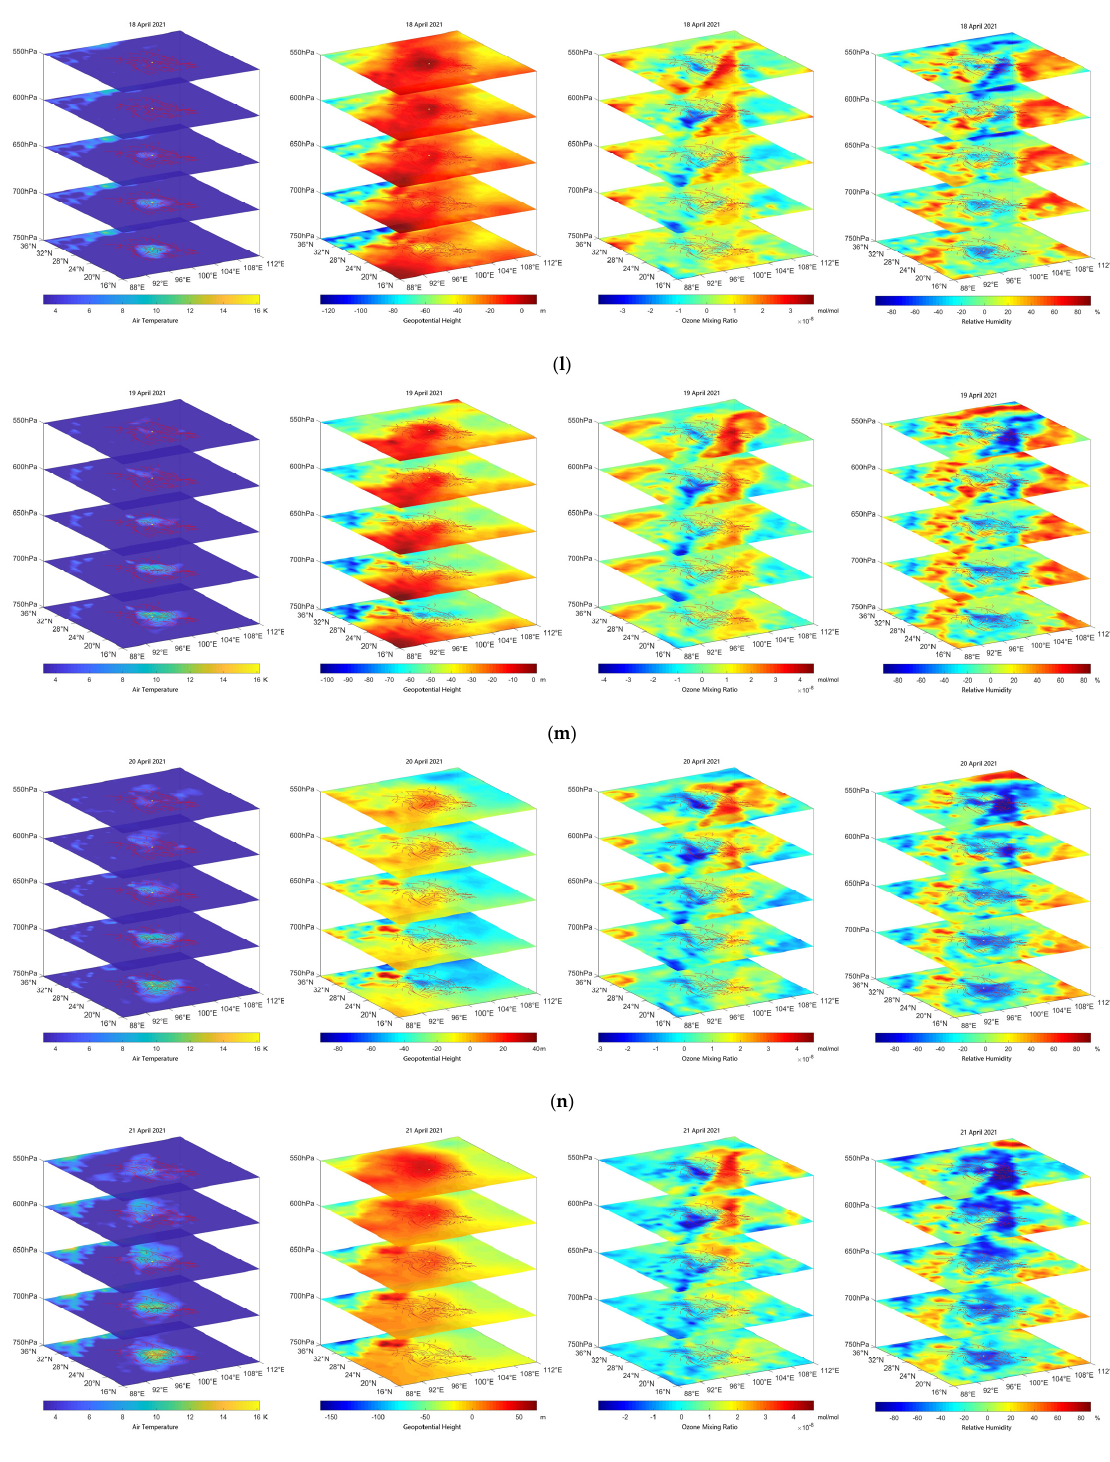
Figure A1. Composite atmospheric anomaly maps during atmospheric thermal anomalies associated with earthquake in Yangbi on ( a ) 7 April; ( b ) 8 April; ( c ) 9 April; ( d ) 10 April; ( e ) 11 April; ( f ) 12 April; ( g ) 13 April; ( h ) 14 April; ( i ) 15 April; ( j ) 16 April; ( k ) 17 April; ( l ) 18 April; ( m ) 19 April; ( n ) 20 April; ( o ) 21 April, 2021. The epicenter and faults are shown by yellow point and red lines, respectively. For each row, the subplots represent air temperature, geopotential height, ozone mixing ratio and relative humidity from left to